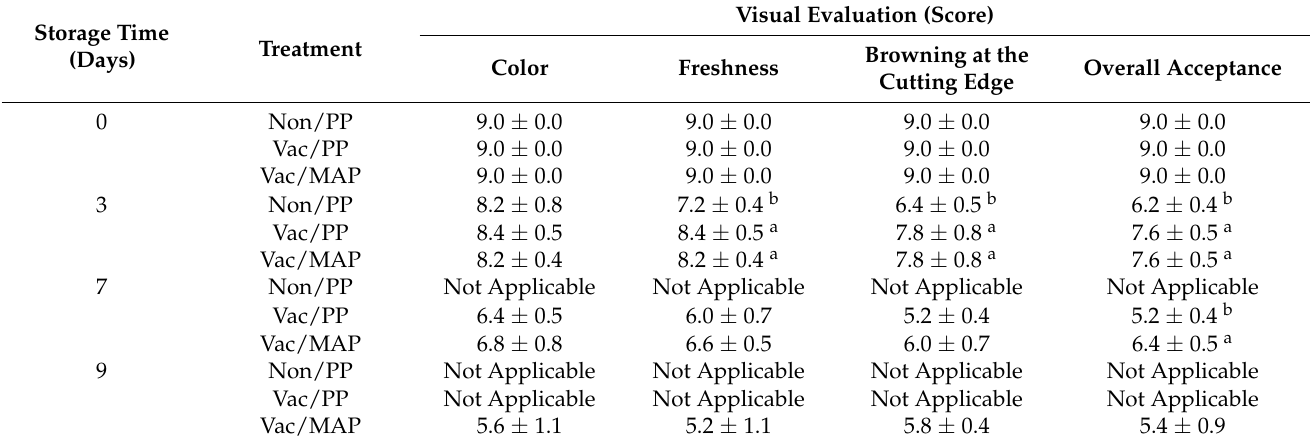
Table 1. Visual evaluation of the whole packaged fresh-cut vegetables during storage at 4 ◦ C using a 9-point hedonic